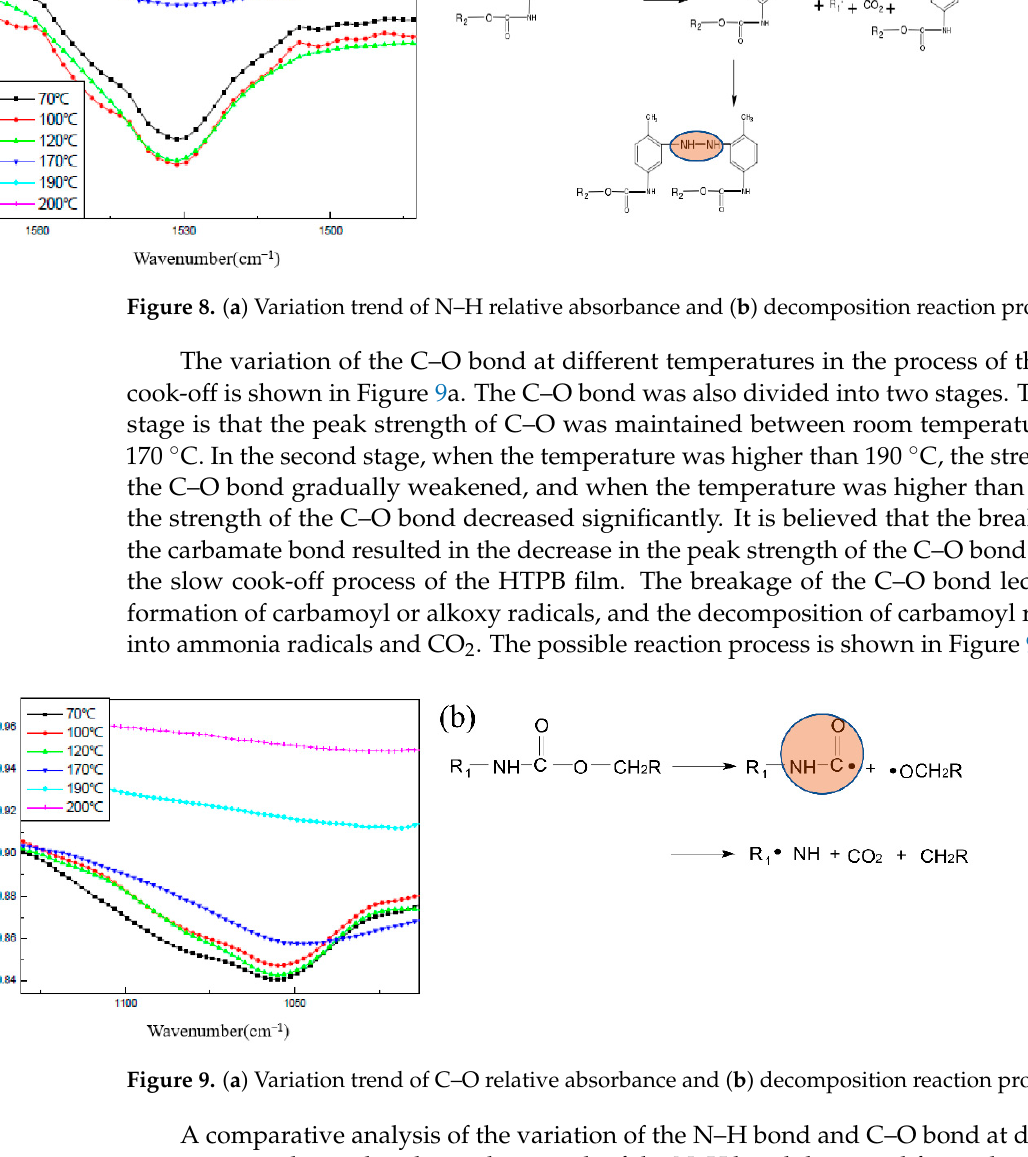
Figure 7. The infrared spectrum of HTPB film at room temperature.